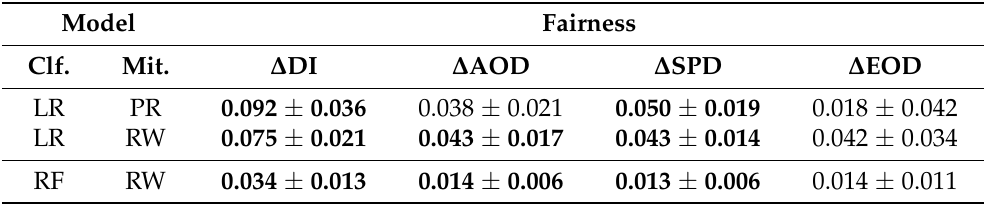
Table 7. Fairness metric differences of models with bias mitigators reweighing (RW) and prejudice remover (PR) compared to a baseline without bias mitigation, for logistic regression (LR) and random forest (RF) classifiers. The fairness metrics are disparate impact (DI), average odds difference (AOD), statistical parity difference (SPD) and equal opportunity difference (EOD). The errors shown are standard deviations. Differences significant at 95% confidence level are shown in bold